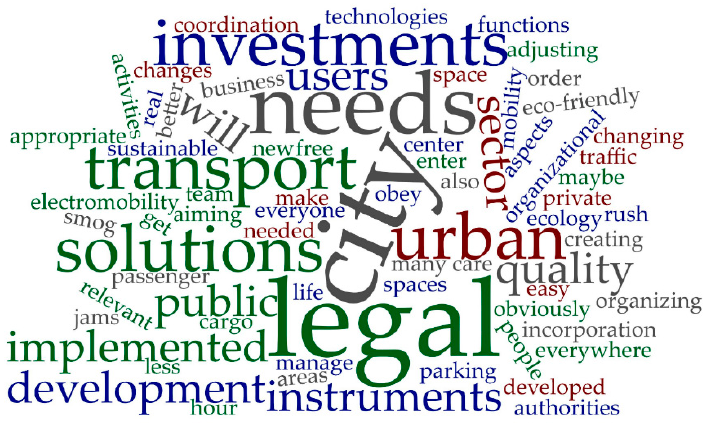
Figure 3. Word cloud for answers to Q4.